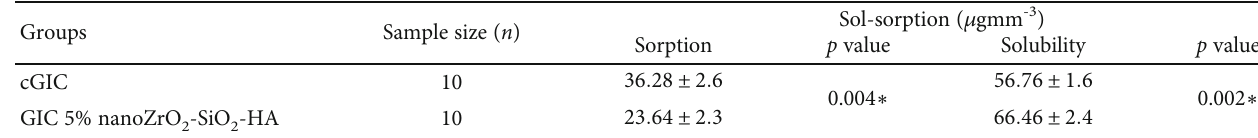
Table 5: Mean sorption- solubility for experimental groups using independent t -test. Groups Sample size ( n